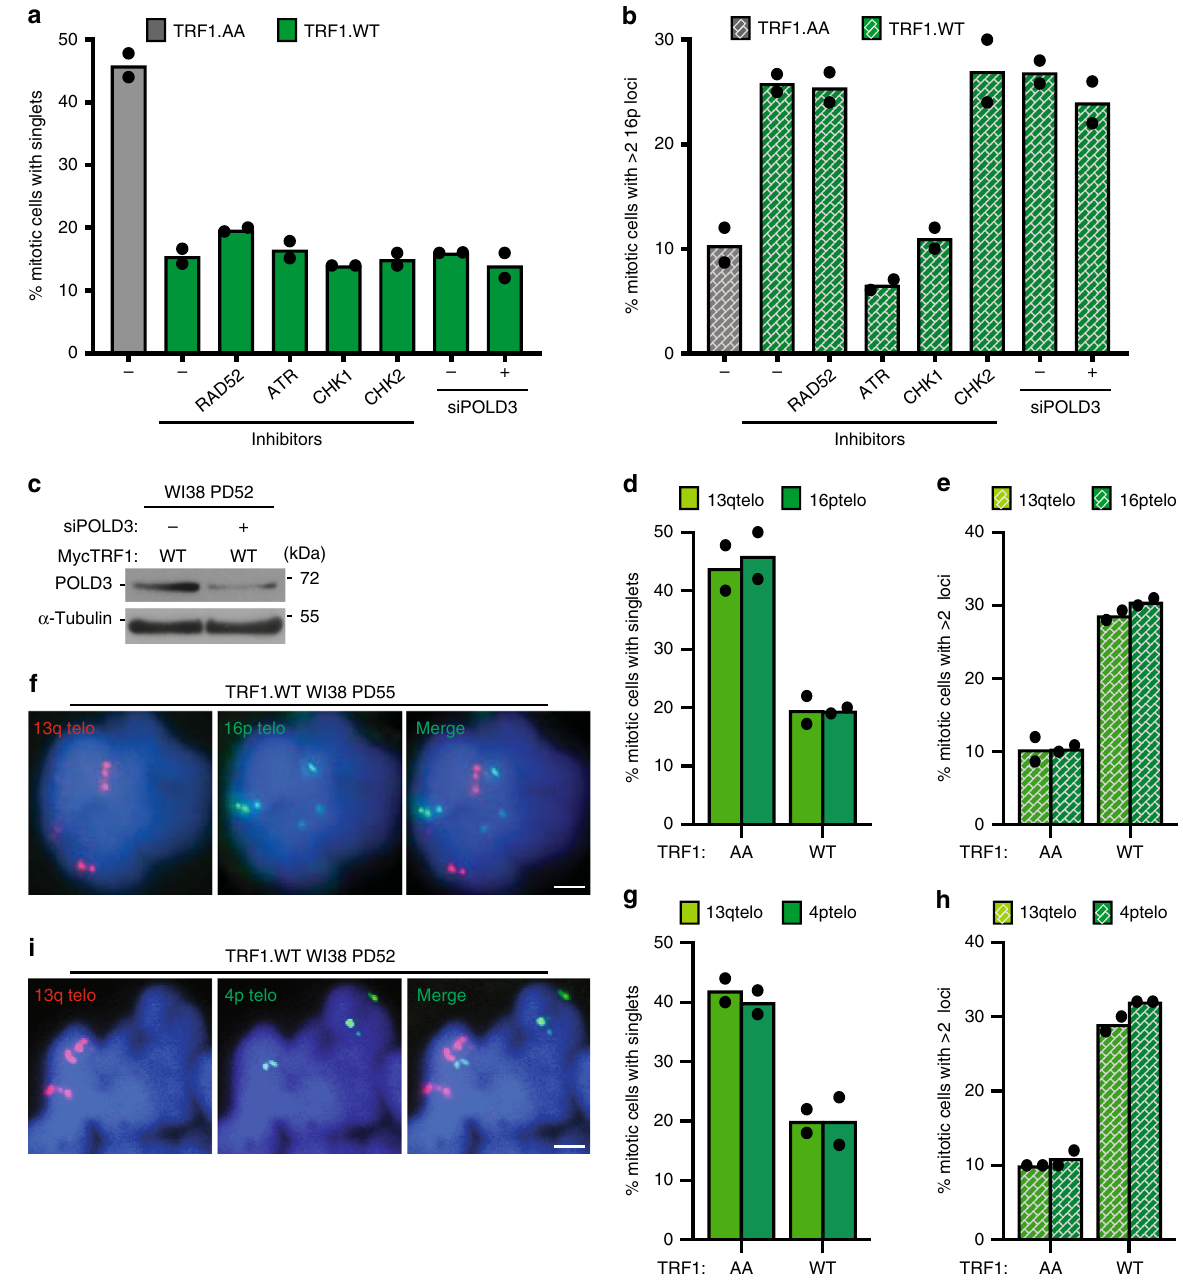
Fig. 2 The mechanism of Rad51-dependent subtelomere recombination. Quanti fi cation of the frequency of TRF1.AA or TRF1.WT transfected late (PD50- 53) WI38 mitotic cells ( a ) with cohered telomeres or ( b ) exhibiting subtelomere copying measured by FISH analysis with a 16p telo probe following treatment with the indicated inhibitors or siRNA. Average of two independent experiments ( n ≥ 25 cells each). c Immunoblot analysis of TRF1.WT- transfected, POLD3 siRNA-treated late (PD52) WI38 cell extracts. d , e Quanti fi cation of the frequency of WI38 TRF1.AA or TRF1.WT transfected late (PD52-55) mitotic cells ( d ) with cohered telomeres or ( e ) exhibiting subtelomere copying measured by dual FISH analysis with 13q and 16p telo probes. Average of two independent experiments ( n ≥ 46 cells each). f FISH analysis of a WI38 TRF1.WT transfected late (PD55) mitotic cell exhibiting subtelomere copying using 13q (red) and 16p (green) telo probes. g , h Quanti fi cation of the frequency of TRF1.AA or TRF1.WT transfected late (PD52) WI38 mitotic cells ( g ) with cohered telomeres or ( h ) exhibiting subtelomere copying measured by dual FISH analysis with 13q and 4p telo probes. Average of two independent experiments ( n = 50 cells each). i FISH analysis of a TRF1.WT transfected late (PD52) WI38 mitotic cell exhibiting subtelomere copying using 13q (red) and 4p (green) telo probes. f , i DNA was stained with DAPI (blue). Scale bars represent 2 μ m. Experiments were repeated independently twice (for c , f , i ) with similar results. Source data are provided as a Source Data fi indicating runaway telomere copying in the absence of increase in subtelomere copying in Vector and TRF1.AA cells checkpoint-mediated growth arrest (Fig. 4i, j). FACS analysis from day 1 to day 4 (Fig. 4j), again indicating that loss of the showed that the increase in copying was not due to an increase in checkpoint reveals a low level of subtelomere copying even with ploidy (Supplementary Fig. 3a). We also observed a slight persistent cohesion.